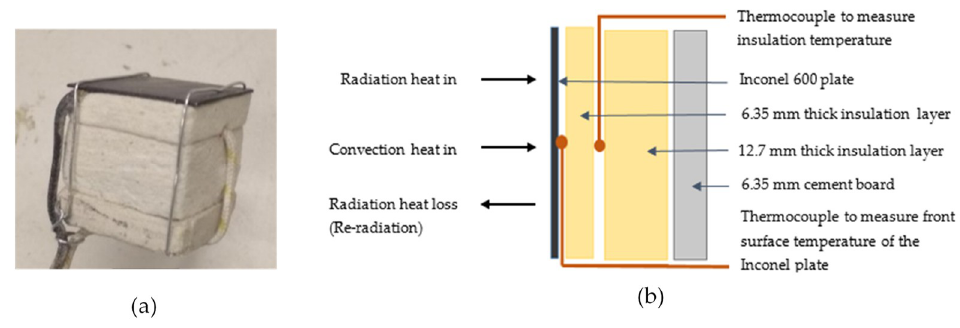
Figure 1. ( a ) Illustration of the PT; ( b ) Components of the PT.